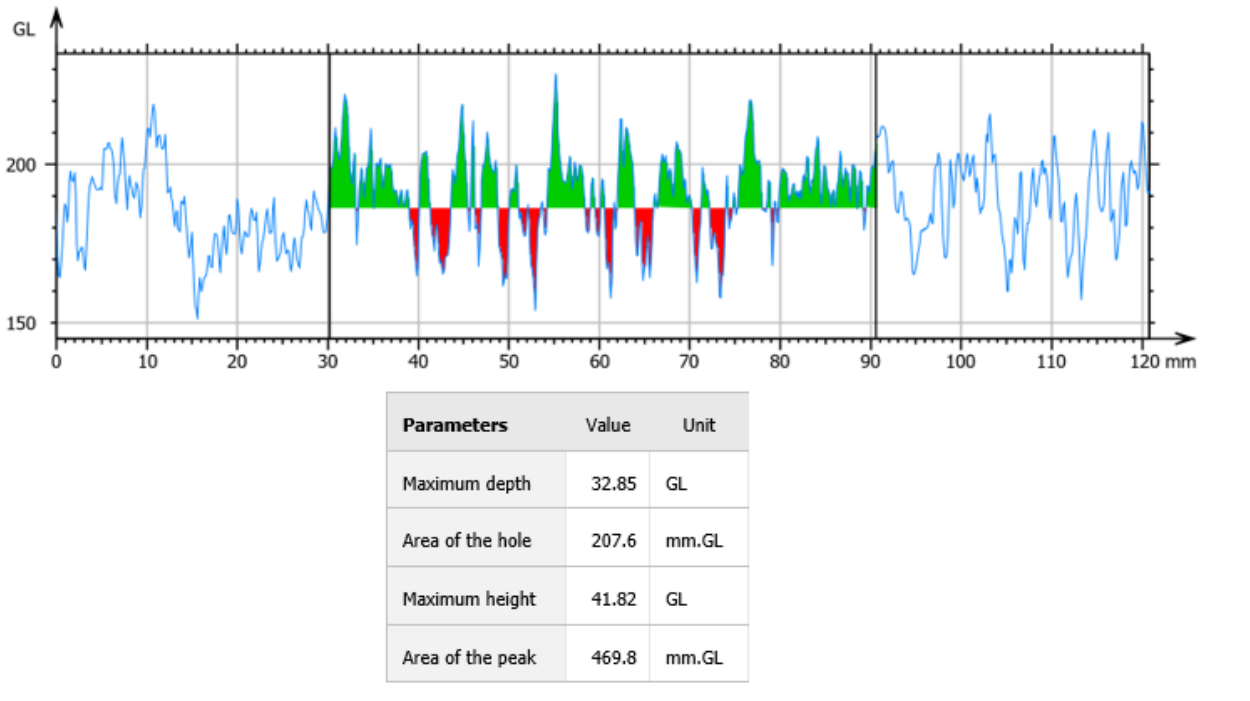
Figure 11. Hole profiles of TiO 2 scaffolds.